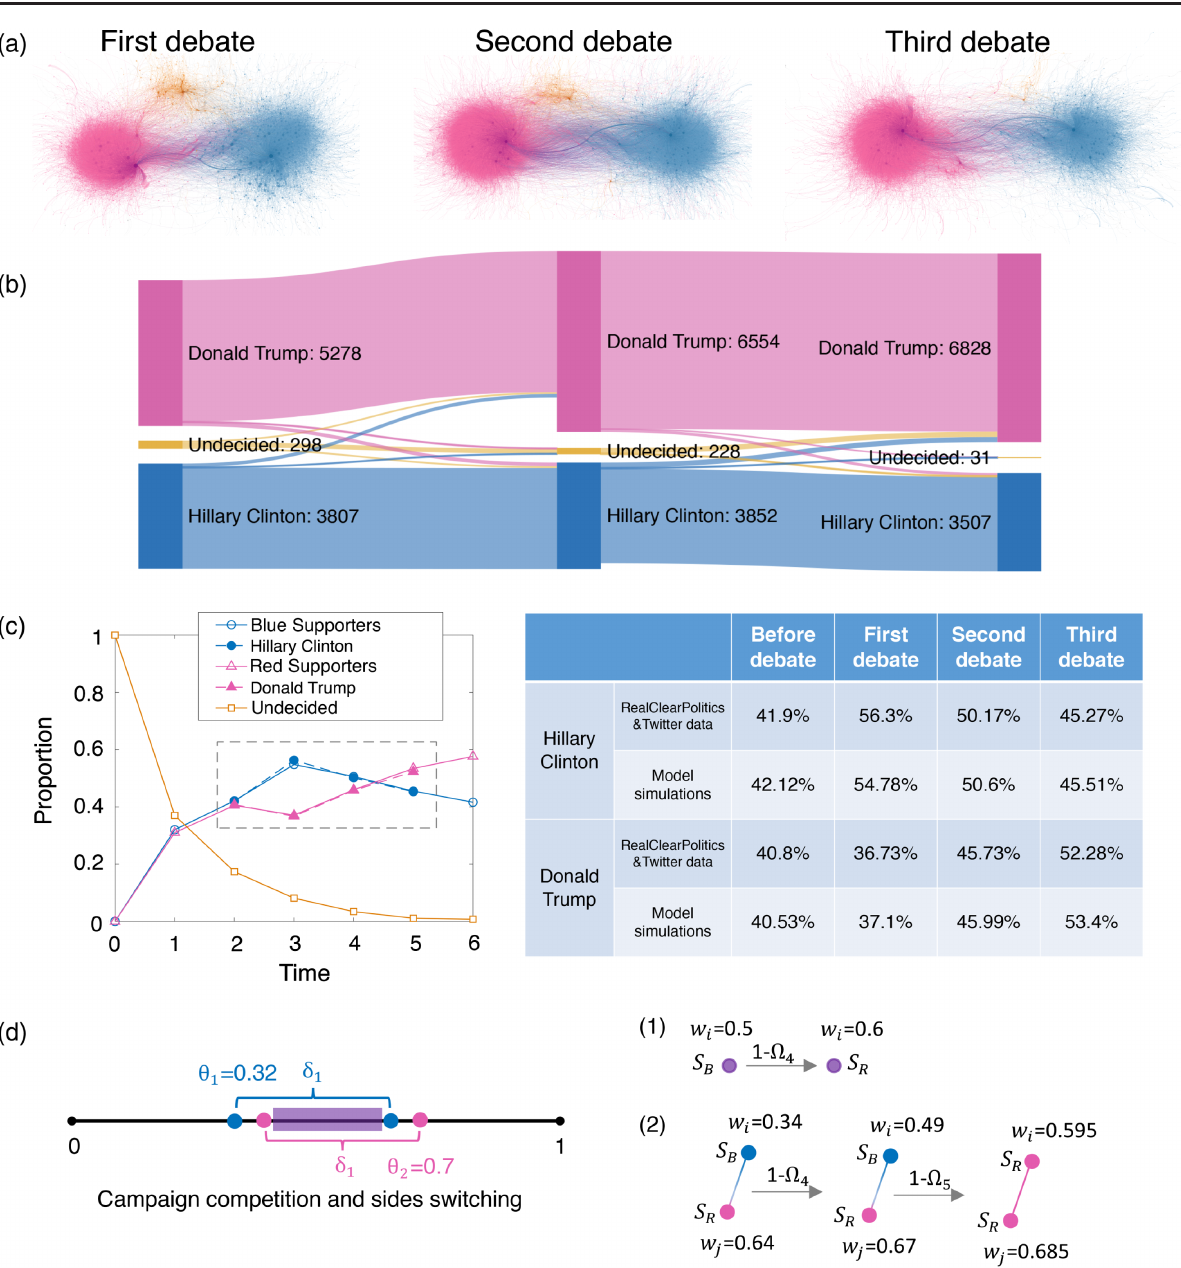
FIG. 7. Model-data integration provides insights into the 2016 U.S. presidential election. (a) Retweet networks of the first, second, and third presidential debates in the 2016 U.S. presidential election show the rise of echo chambers that gradually absorb undecided voters. (b) Sankey diagram of individual-level opinion evolution for Twitter users between the first and second debates and the second and third debates. Most Donald Trump or Hillary Clinton supporters are “ loyal followers who would not change their political tendency from beginning to end. ” (c) Reproduction of opinion evolution processes in the 2016 U.S. presidential election using an agent-based model. We take the Real Clear Politics polling average on September 15, 2016, as an initial estimate of predebate support, while, from the first to third debates, we use the same Twitter data as in (a). Fixing a middle level of confirmation bias ( μ 1 ¼ μ 2 ¼ 0 . 5 ), we find a group of best- fitting parameters for the ideological positions of campaigns, the identity scope (open-mindedness) of voters, and relative levels of campaign effort: θ 1 ¼ 0 . 32 , θ 2 ¼ 0 . 7 , δ 1 ¼ 0 . 32 , Ω 1 ¼ Ω 2 ¼ 0 . 5 , Ω 3 ¼ 0 . 8 , Ω 4 ¼ 0 . 4 , and Ω 5 ¼ 0 . 1 (we let Ω 6 ¼ Ω 5 ¼ 0 . 1 to model one extra time step). Each result in the figure is the average of 100 simulations. (d) Illustration of the potential mechanisms that lead to side switching within this model (in this case, from blue supporter to red supporter). Two possible ways are shown: (1) a blue supporter within ideological range of both candidates switches via one single update as a result of campaigning; (2) switch via multiple updates, a voter is not persuaded by the candidate initially but instead talks to a discussion partner within their range who is a red supporter and then updates their beliefs. In the next time step, the voter is reached by the red campaign again and is close enough to the red candidate to be